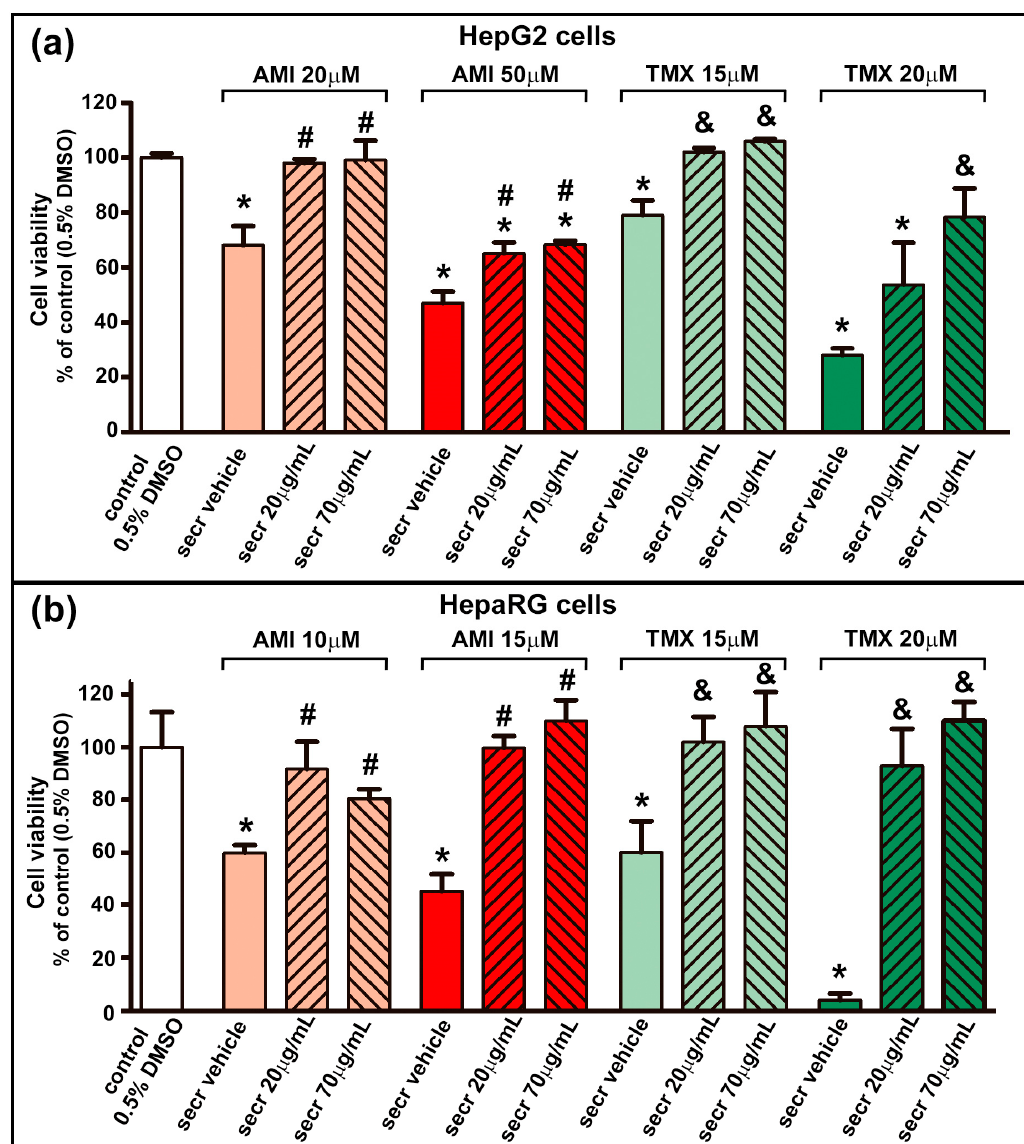
Figure 1. MSC secretome presented a cytoprotective effect in hepatic cells incubated with AMI or TMX. To determine the cytoprotective effect of MSC secretome on ( a ) HepG2 and ( b ) HepaRG cells, both cell lines were incubated with AMI (light and dark red bars) or TMX (light and dark green bars) at the indicated concentrations, alone or coincubated with two concentrations of MSC secretome (20 or 70 µg/mL—line pattern bars), or the secretome vehicle (PBS) for 24 h. As a control group, cells were incubated with the drug solvent (0.5% DMSO—white bars). Cell viability was measured by an MTT assay at the end of the treatment, and control group value was obtained as 100%. AMI and TMX significantly decreased cell viability in both cell types in a concentration-dependent manner, while coincubation with MSC secretome (both concentrations) led to increased cell viability in both cell lines. Data are presented as means ± SEM ( n = 4) of three independent experiments. * p < 0.05 vs. control group (0.5% DMSO); # p < 0.05 vs. AMI plus secretome vehicle, of the same experi- mental group (same AMI concentration); & p < 0.05 vs. TMX plus secretome vehicle, of the same experimental group (same TMX concentration). secr vehicle: MSC secretome vehicle (PBS); secr: MSC secretome; AMI: amiodarone; TMX: tamoxifen.